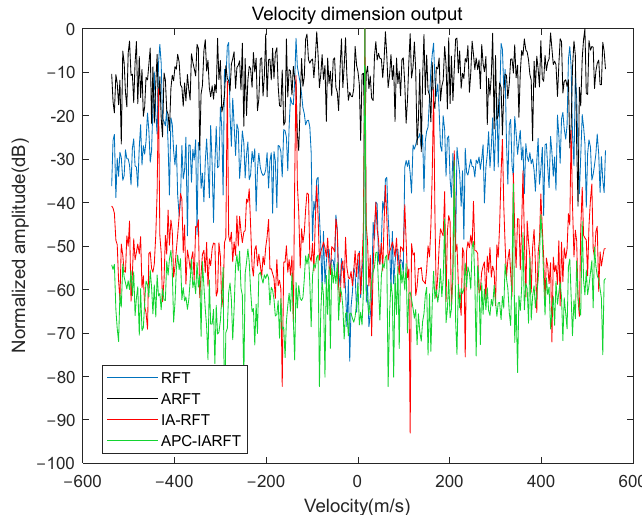
Figure 10. Velocity-dimension output of four methods in Scenario 2.